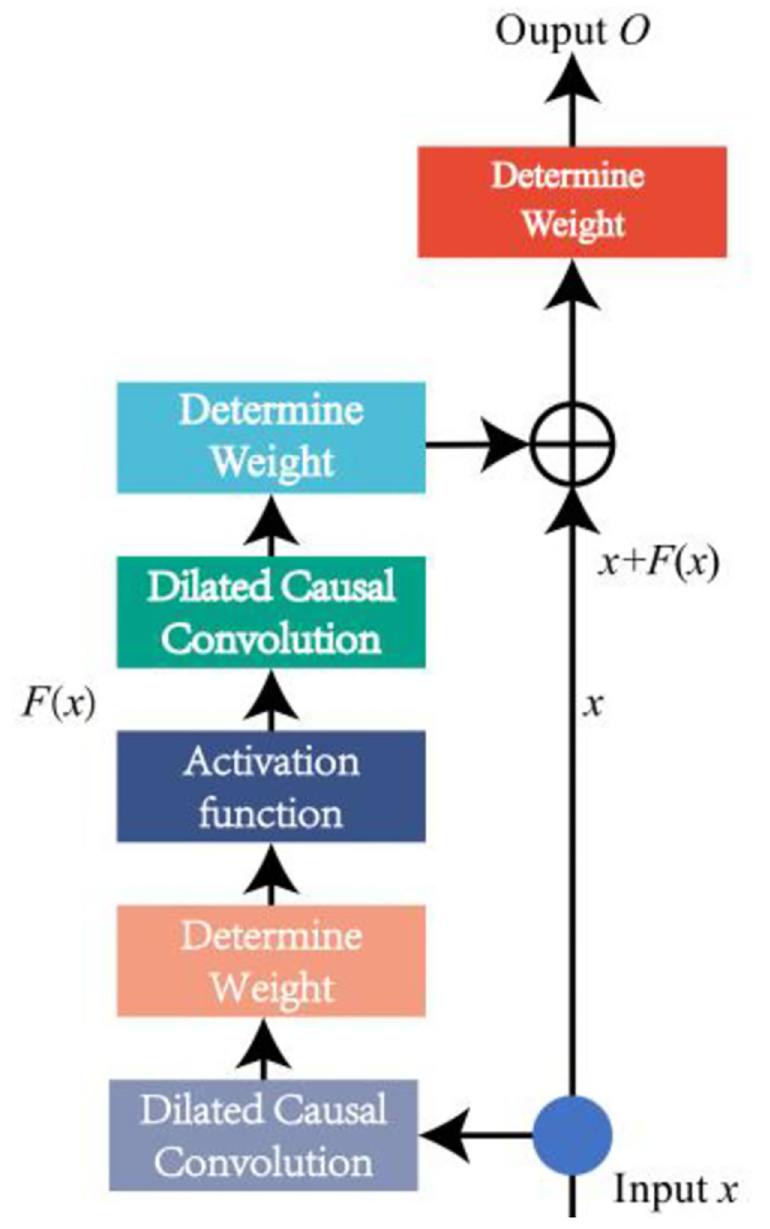
Fig 4. General structure of residual